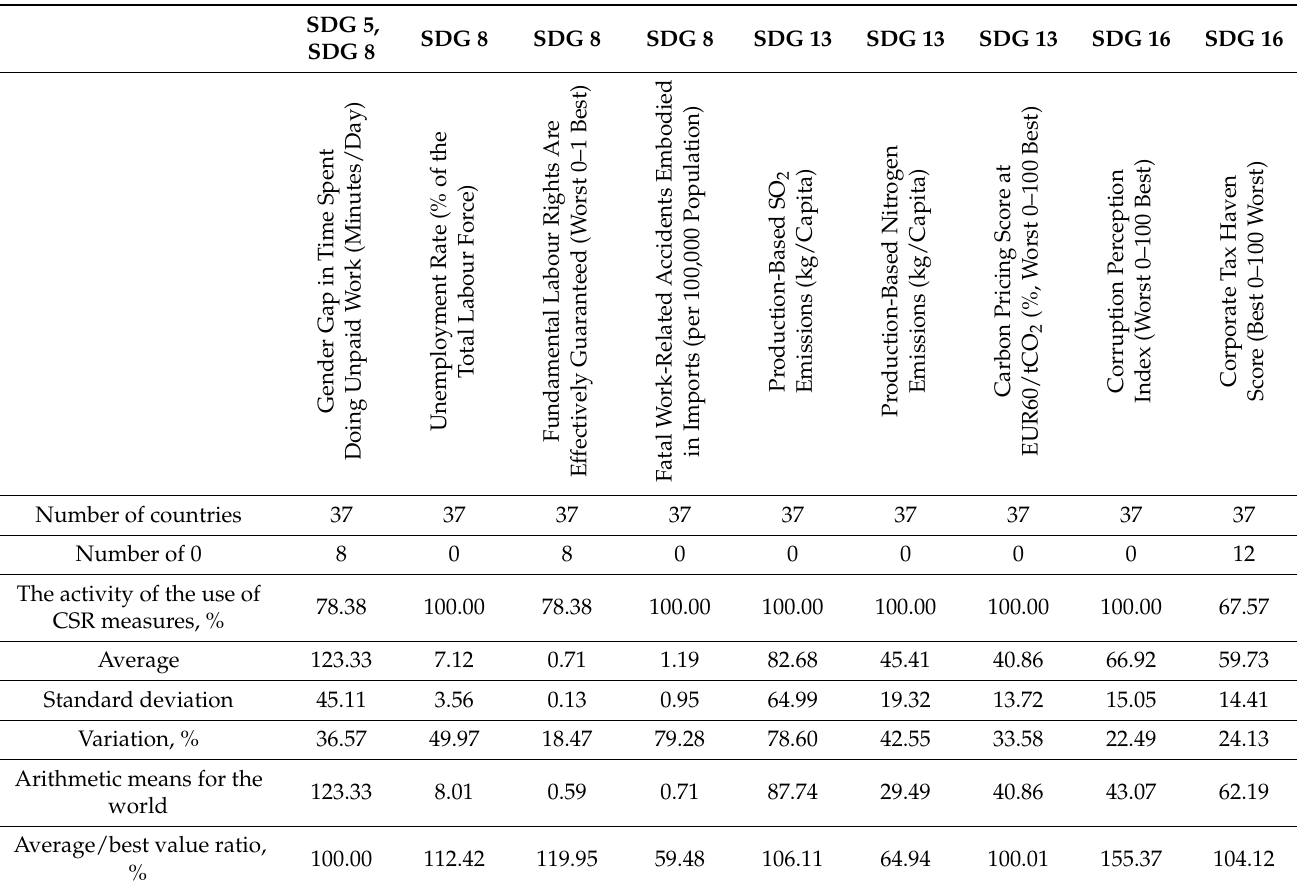
Table 10. Representation of the CSR practices to support the SDGs (UN standards) in countries of OECD in 2021.